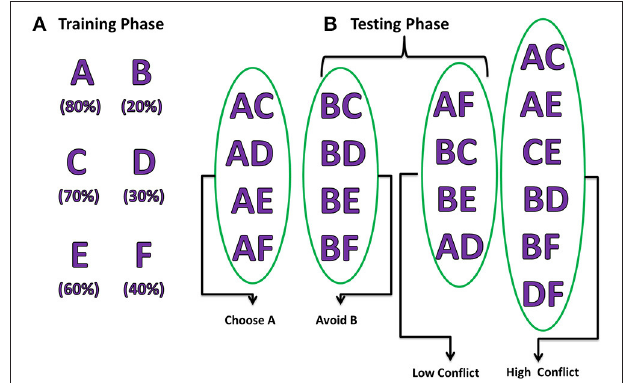
FIGURE 2 | Pictorial representation of probabilistic learning task (Frank et al., 2007) indicating training and testing stages. The percentages below each choice in the training phase indicate their corresponding reward probabilities. The testing stage is divided into 2 steps: (A) Positive/Negative learning testing the “Choose A” and “Avoid B” ( Frank et al., 2007), (B) test reaction time during LC and HC